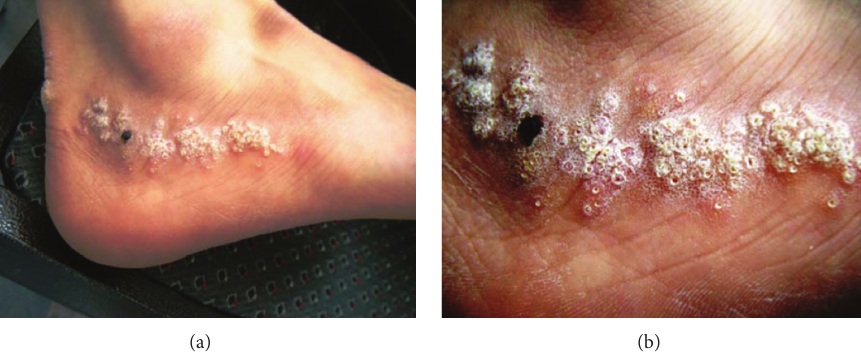
Figure 1: Linearly distributed multiple keratotic papules of a similar size on the lower part of the right lateral ankle. He had no personal history of extracutaneous disease and no family history of similar lesions.